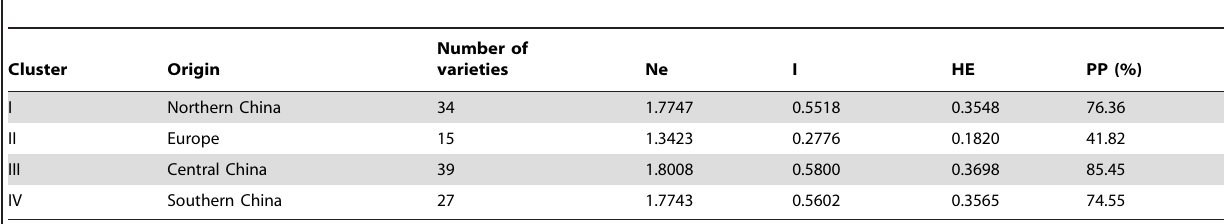
Table 3. Variability parameters in 4 groups of